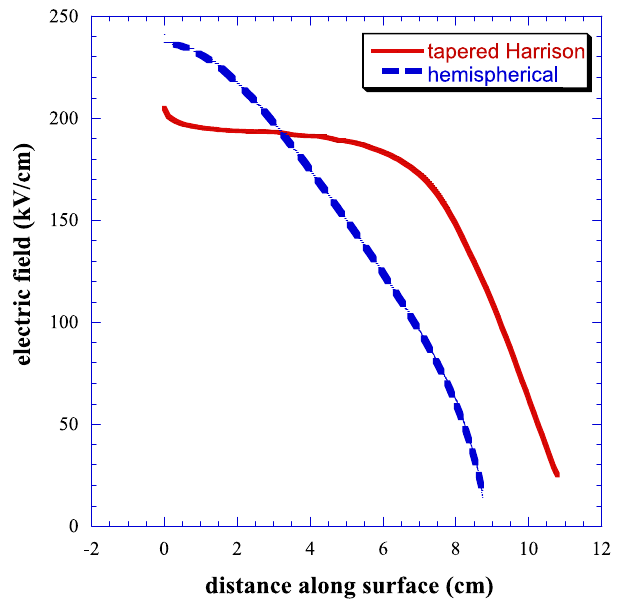
FIG. 9. (Color) Trigger electrode surface electric field for the modified-Harrison and hemispherical profiles. d (cid:2) 0 is at the axial center ( (cid:3) (cid:2) 0 ) of the switch and d increases along the surface with increasing (cid:3) .